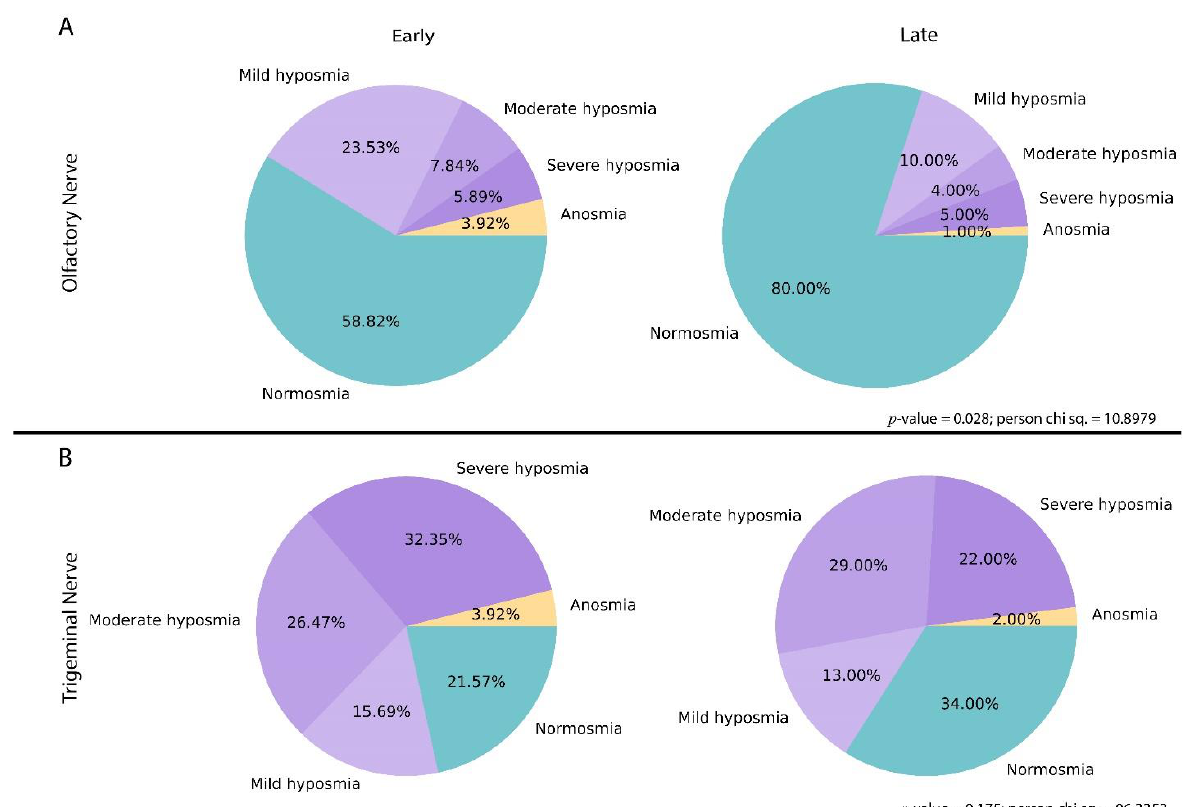
Figure 3. The sensory tests of the olfactory and trigeminal nerves among the participants of the early and late groups. ( A ) Results of the olfactory nerve sensory test among the early and late groups. ( B ) Results of the trigeminal nerve sensory test among the early and late groups.